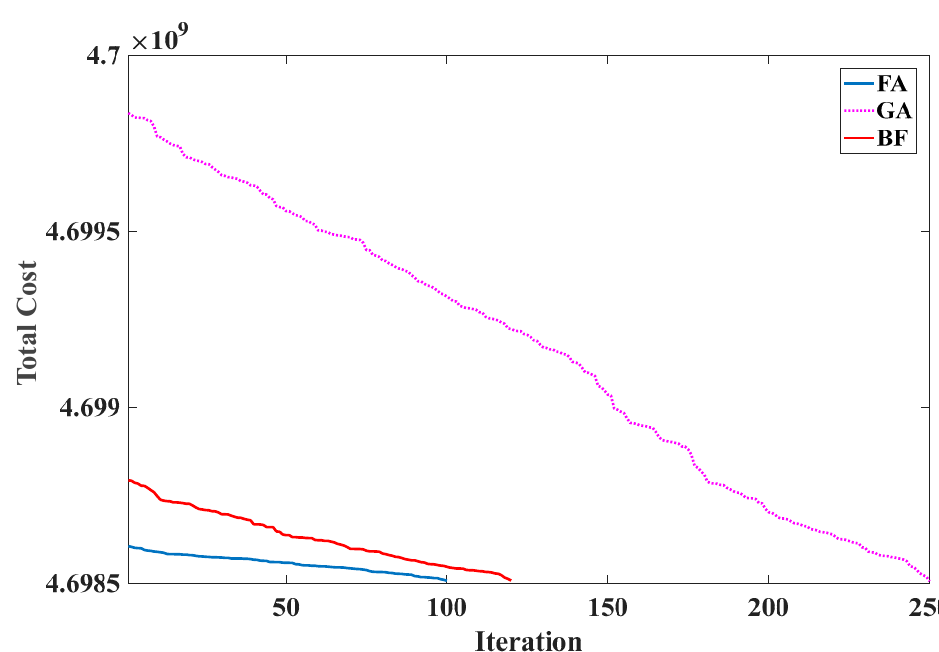
Figure 10. Convergence process of the IPS algorithm.